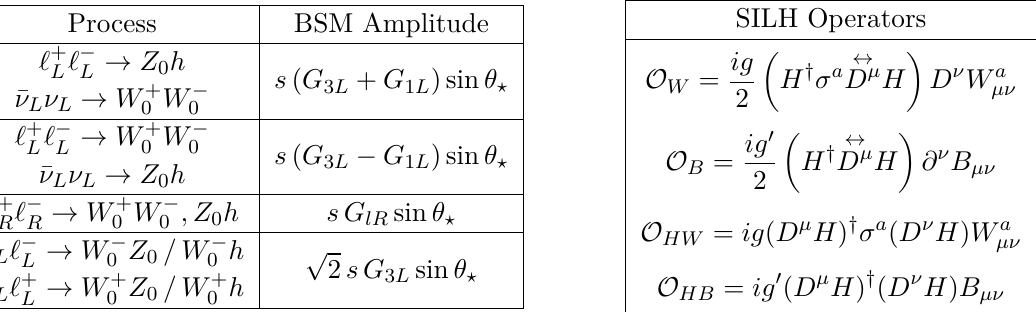
Table 1 . Left: bSM contributions to diboson production amplitudes that grow with energy. The center of mass energy and scattering angle are denoted as basis